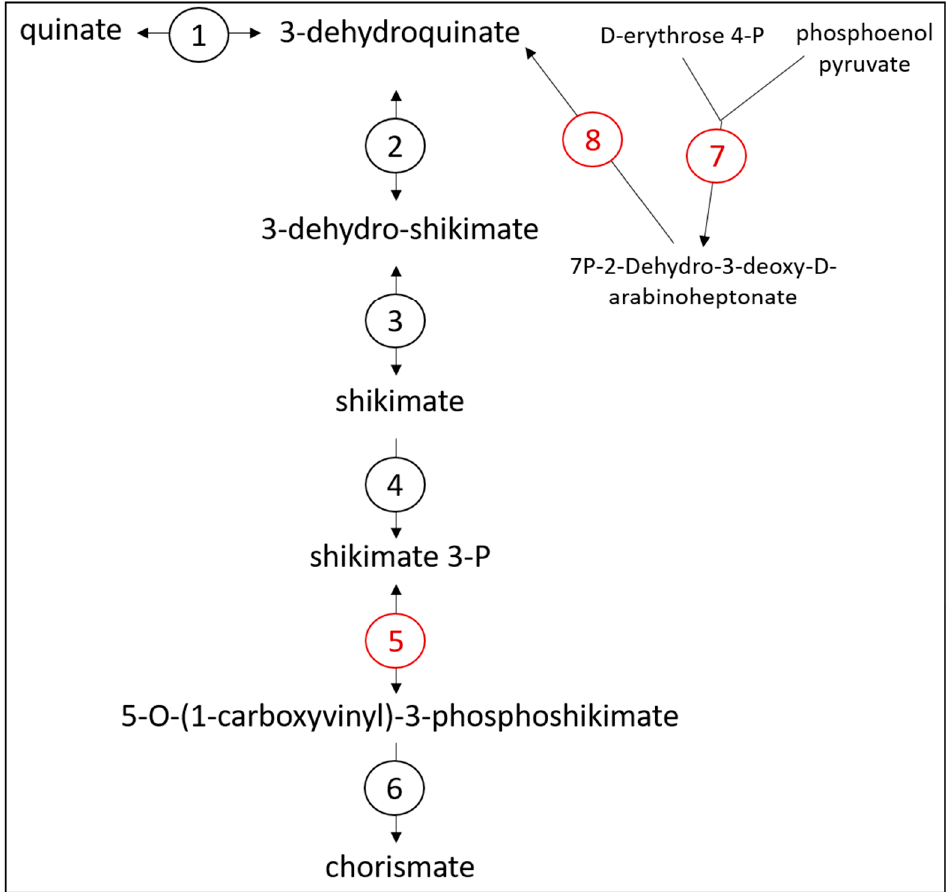
Figure 4. Proposed chorismate synthesis pathway for Bt-01708_Bf. The main precursors for chorismate synthesis are quinate (plant compound) or phosphoenol pyruvate (glycolysis) + D-erythrose 4-P (pentose phosphate pathway). Enzymes labeled in black were encoded in the contig set for Bt-01708_Bf, while enzymes shown in red were not found. Key for enzyme legend: (1) shikimate/quinate 5-dehydrogenase (EC 1.1.1.282); (2) 3-dehydroquinate dehydratase II (EC 4.2.1.10); (3) shikimate 5-dehydrogenase I alpha (EC 1.1.1.25); (4) shikimate kinase I (EC 2.7.1.71); (5) 5-enol-pyruvylshikimate-3-phosphate synthase (EC 2.5.1.19); (6) chorismate synthase (EC 4.2.3.5); (7) 3-deoxy-7-phosphoheptulonate synthase (EC 2.5.1.54; (8) 3-dehydroquinate synthase (EC 4.2.3.4).